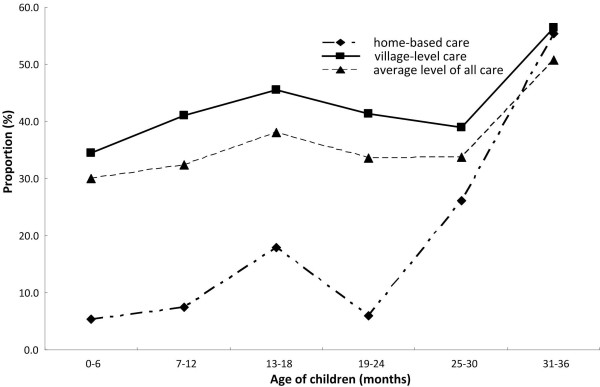
ORS use for diarrhea in the 6 age-groups by home-base care, village-level care and average level of all care among children under 36 months old in rural Western China.